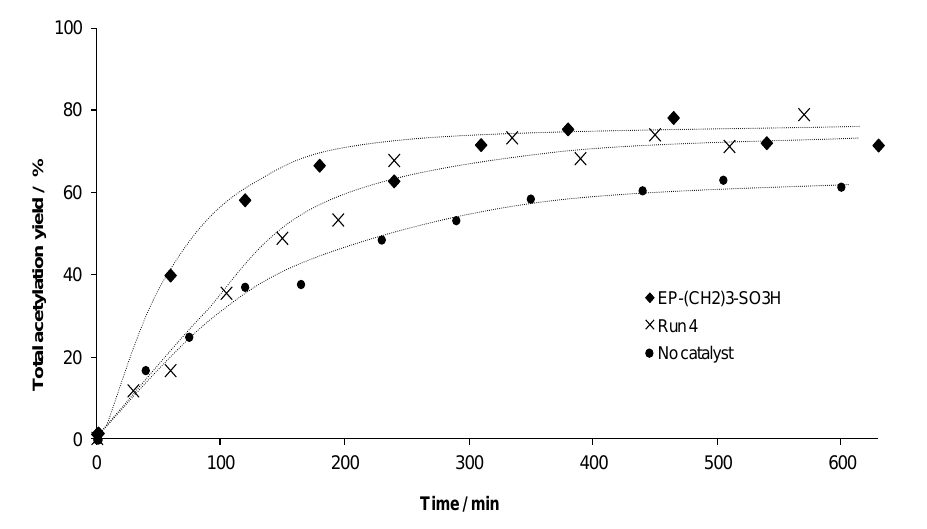
) –SO H: a comparison between the 2 3 3